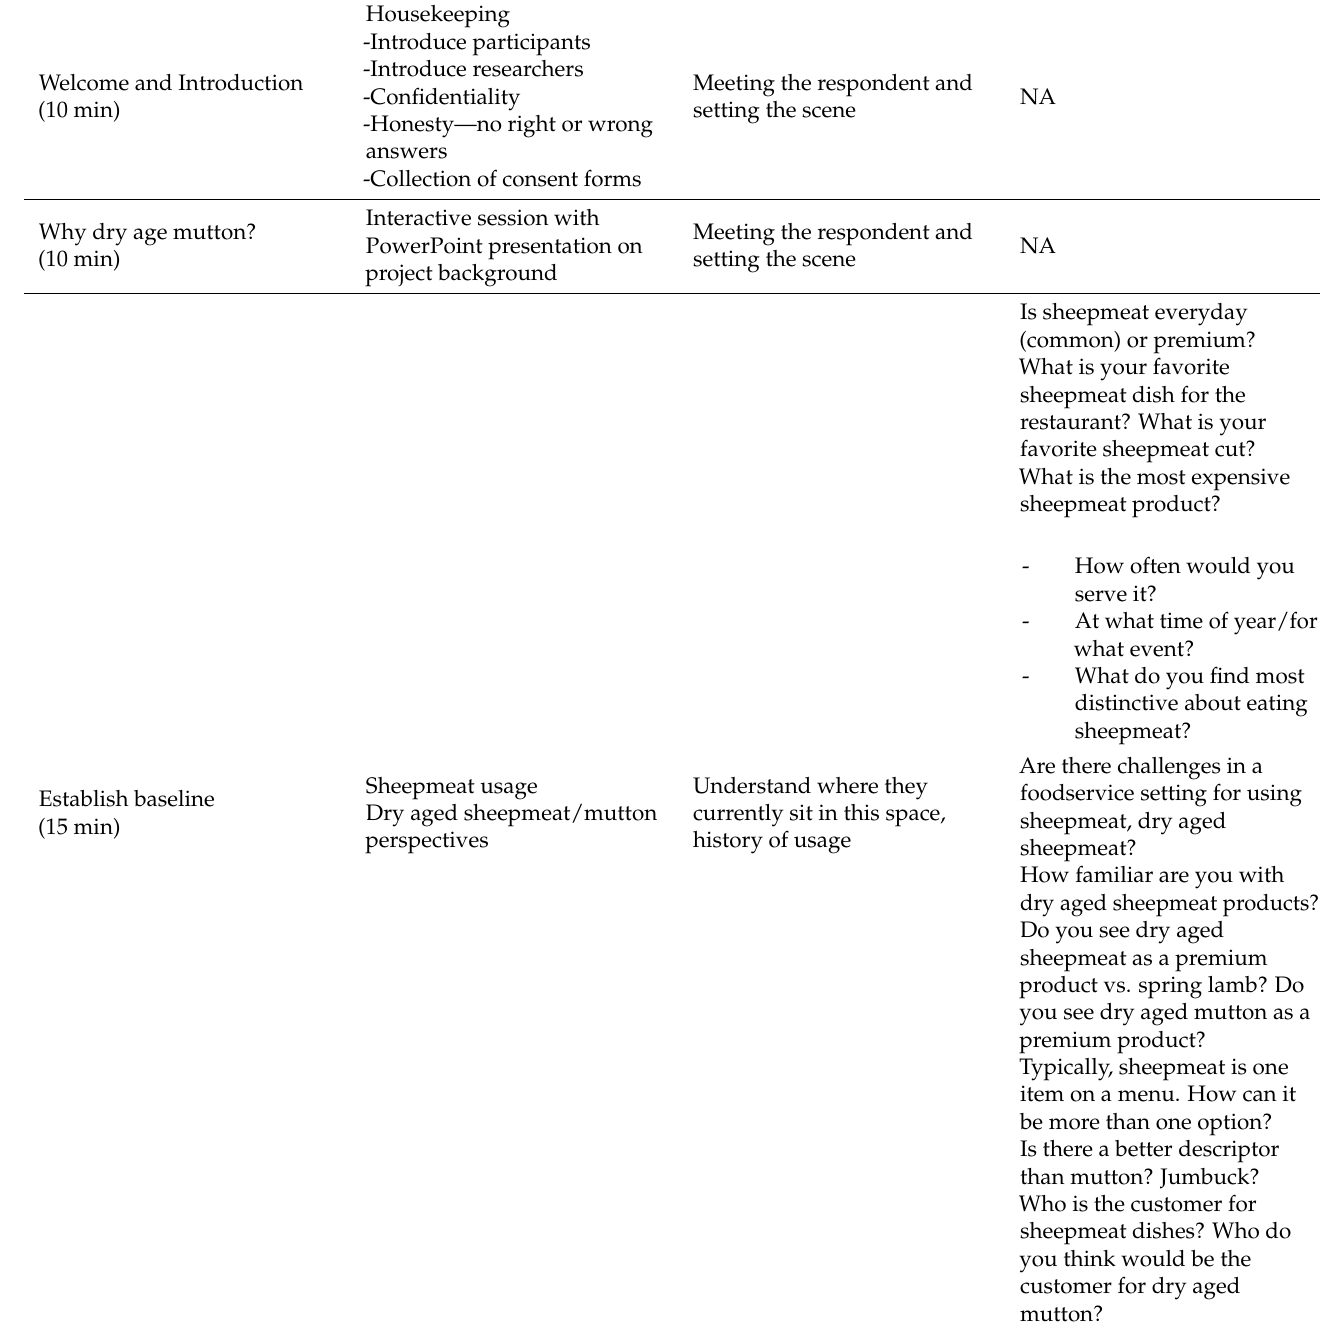
Table A2. Ideation session results (dishes and concepts) and result of review for inclusion in perceptual mapping.